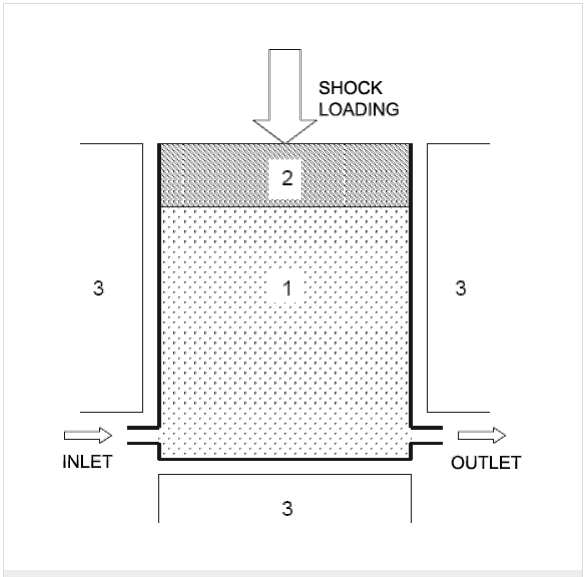
Figure 1: A conceptual design of a device for cavitation separation of gold-bearing particles. (1) Cavitation chamber with liquid (water) containing ore microparticles; (2) plunger providing shock loading (an abrupt rise in pressure in the chamber to 10–15 bar); (3) thermostat maintaining a temperature T 0 = 373 K in the cavitation